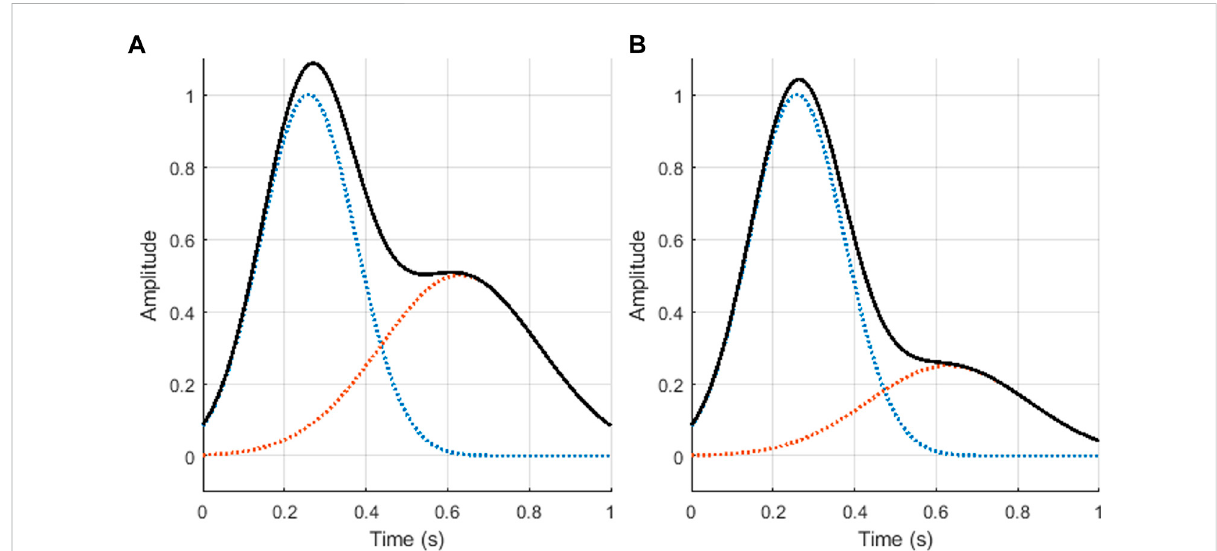
FIGURE 1 Photoplethysmographic cardiac cycles generated using the proposed mode, using ratios of value (A) r = 2 (excellent quality), and (B) r = 4 (acceptable quality). The blue and orange dotted lines illustrate the two Gaussian functions generated, while the black continuous line shows the result of summing these two Gaussian functions, i.e., z